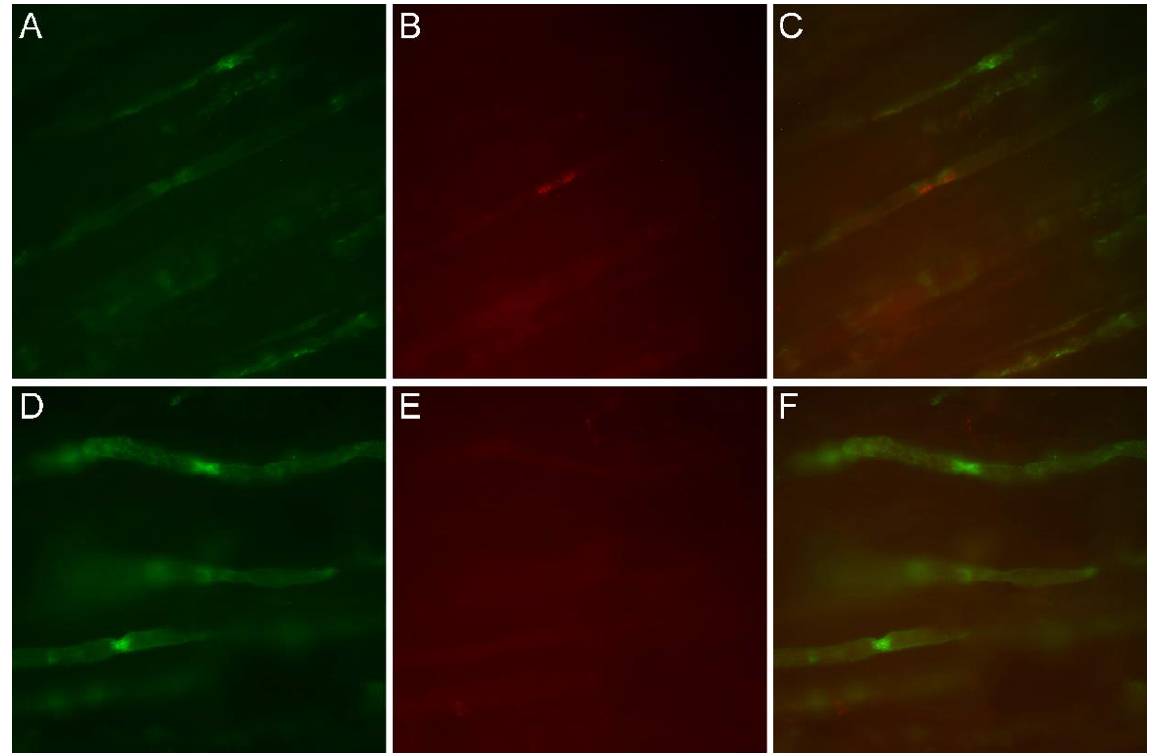
Figure 4. Immunofluorescence study on nerve longitudinal sections, comparing patient III-8 ( D – F ) to a normal control ( A – C ). Original magnification 40×. ( A , D ) Green immunofluorescence following reaction with anti-MAG antibodies. ( B , E ) Red immunofluorescence using anti-Cx32 antibodies. ( C , F ) Merged images. In the control nerve sample, anti-MAG and anti-Cx32 antibodies colocalized at the paranodes ( C ), whereas in the patient, Cx32 signal was lacking ( E ) and the sole anti-MAG immunofluorescence was observed in merged images ( F ).